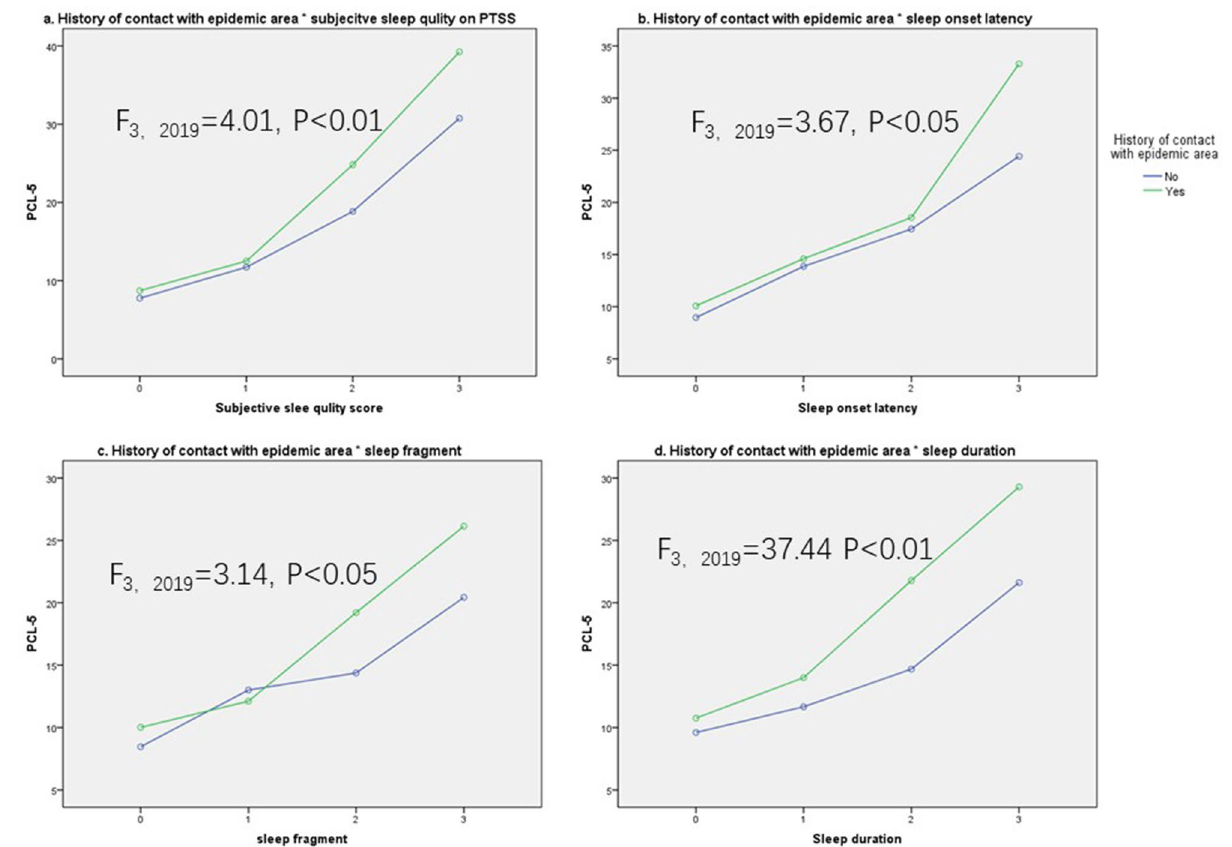
Figure 4. The interaction effect of history of contact with epidemic area × sleep quality on PTSS. PCL-5 PTSD Checklist for